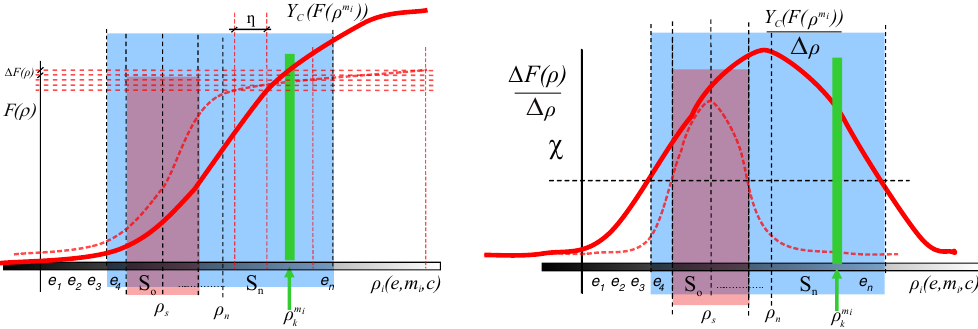
Figure 5. Outline for a transformation Υ C able to increase differences of input magnitudes values until the change is perceptible in the output F . Dotted line curve and light red area represents the old calibration and S o respectively of the VAS . Red line curve and blue area represent the new calibration curve and the new S n . The vertical dotted red lines represent values of the set A that allow perceptible changes in the output (horizontal dotted red